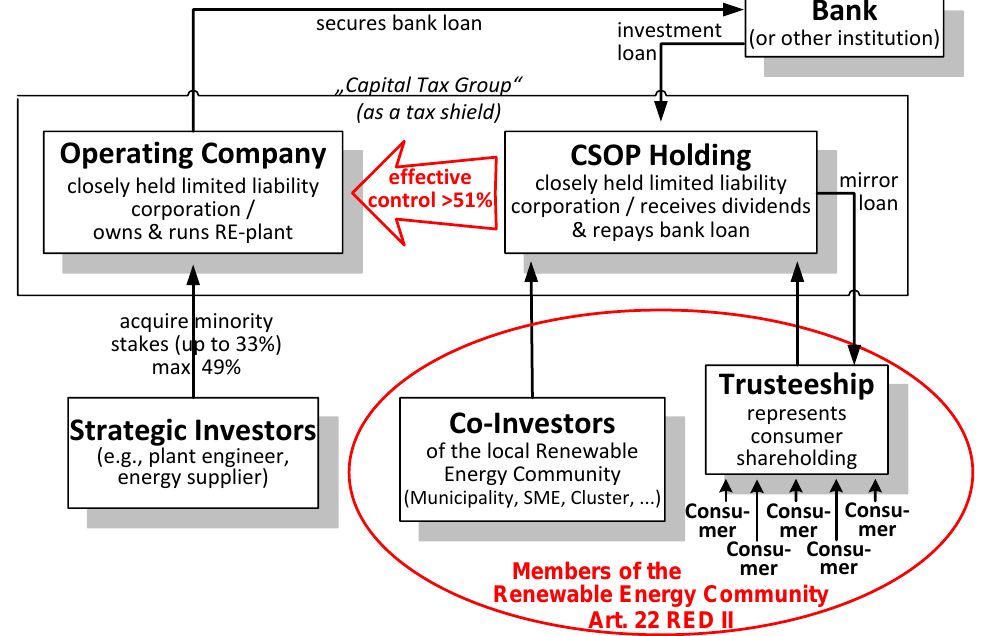
Figure 4. Key elements of the leveraged RE-CSOP with strategic investors for a REC at Level II. (Source: Own elaboration).